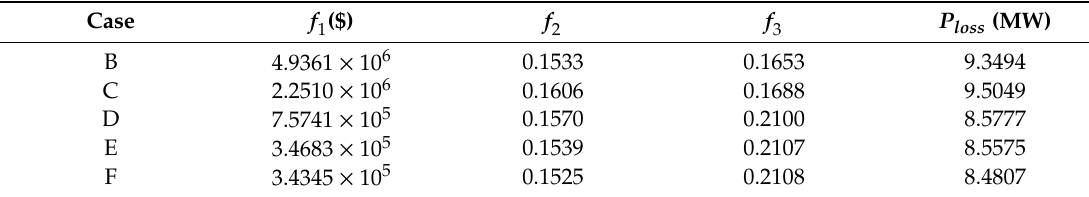
Table 21. Comparison of di ff erent